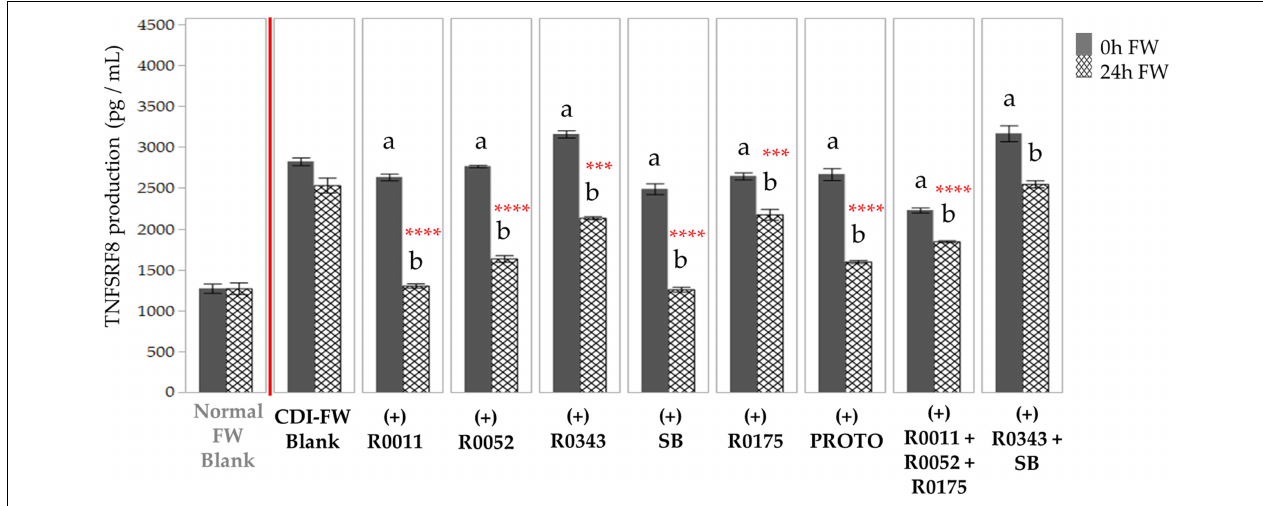
FIGURE 6 | Detection of tumor necrosis factor receptor superfamily member 8 production following the exposure of T84 cells with Clostridioides difficile -infected (CDI) fecal water (FW) treatments as measured by multiplex assay. , cells treated with FW collected at T = 0 h; , cells treated with FW collected at T = 24 h. Values are shown as mean ± SEM. Means at time points within treatments without a common letter are significantly different from each other ( p < 0.05). The symbol * represents significant differences (*** p < 0.001; **** p < 0.0001) between treatment and CDI-FW blank at T = 24 h. R0011 = L. rhamnosus R0011; R0052 = L. helveticus R0052; R0343 = L. rhamnosus GG R0343; SB = S. boulardii CNCM I-1079; R0175 = B. longum R0175; PROTO = ProtecFlorTM; R0011 + R0052 + R0175 = combination of L. rhamnosus R0011, L. helveticus R0052 and B. longum R0175; R0343 + SB = combination of L. rhamnosus GG R0343 and S. boulardii CNCM I-1079.